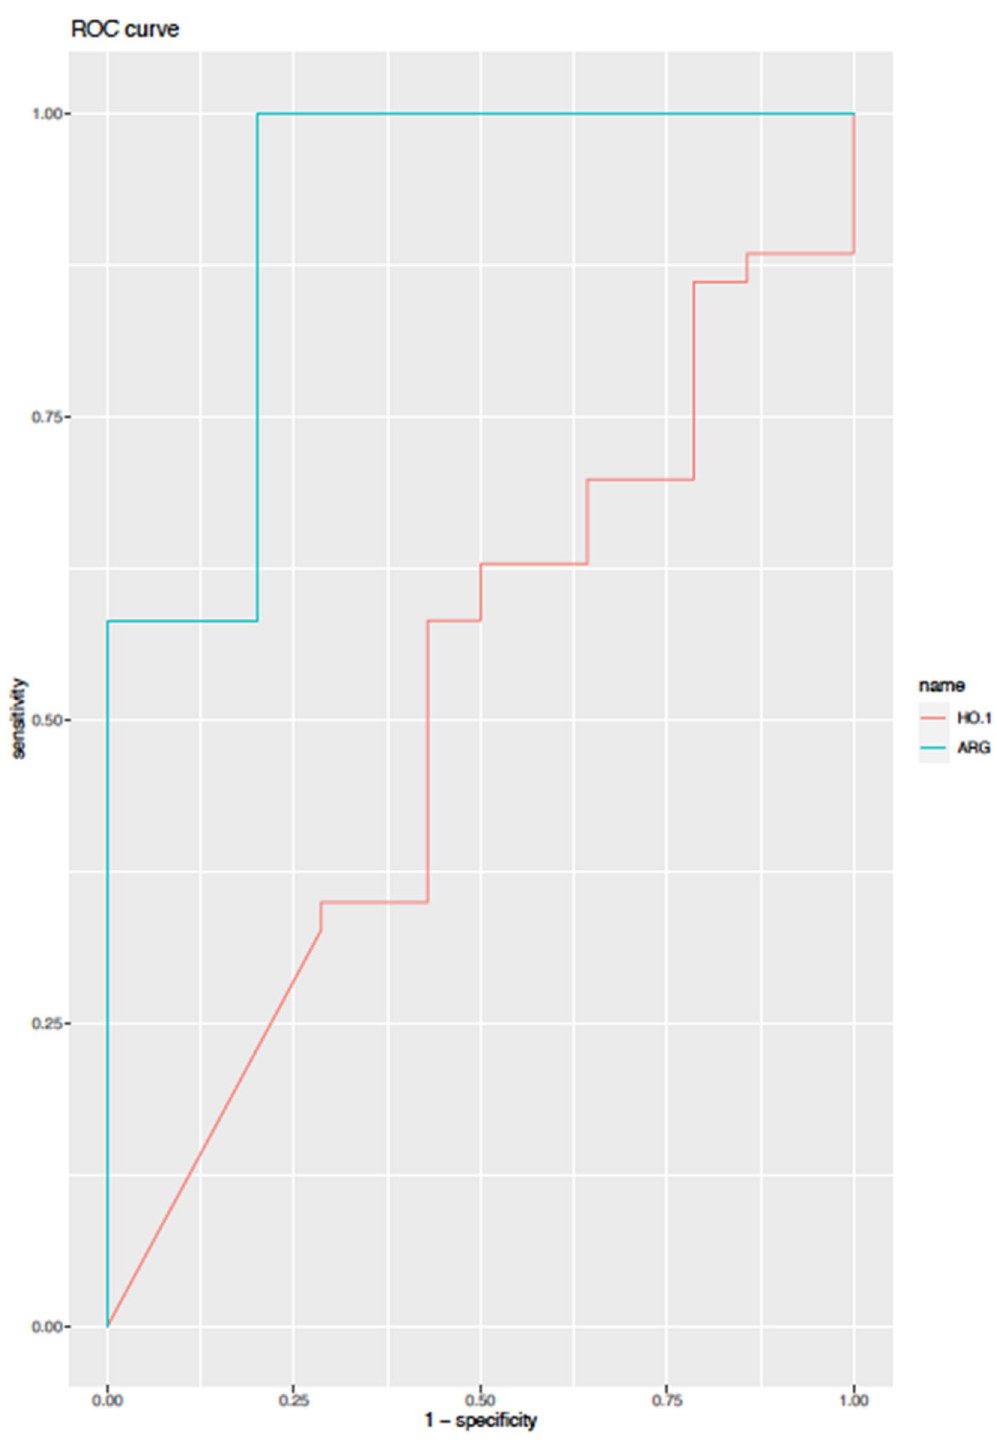
Figure 3. Evaluation of HO-1 and Arginase as predictive markers of illness in leprosy contacts. Receiver operating characteristic curves (ROC) for contacts showing the two markers tested (HO-1, red and Arginase,